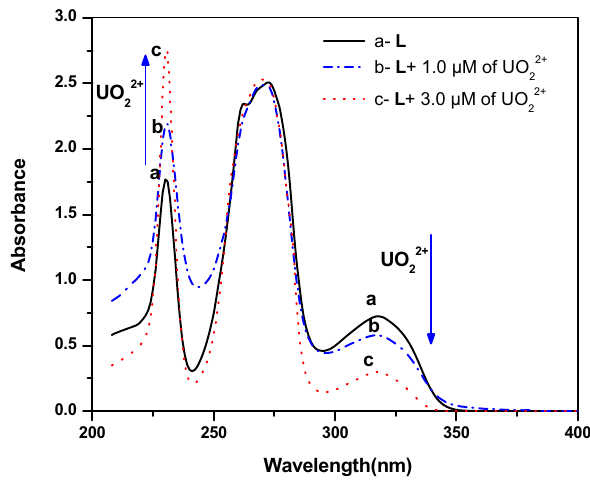
Figure 1: Absorbance spectra of the L sensor in the presence of di ff erent concentrations of UO 22 + .